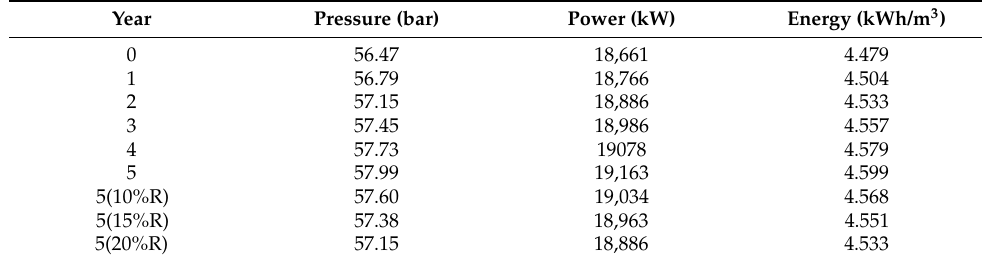
Table 6. Pressure, Power, and Energy consumption at 27 ◦ C.